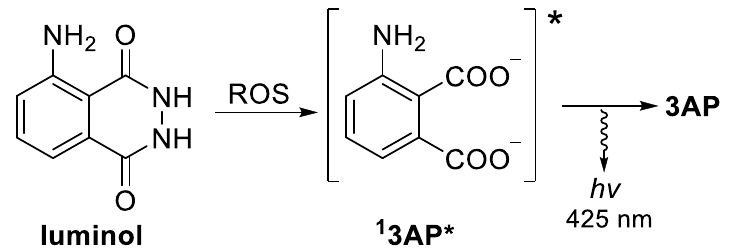
Figure 1. ROS triggered luminol CL reaction, producing 3AP and light.